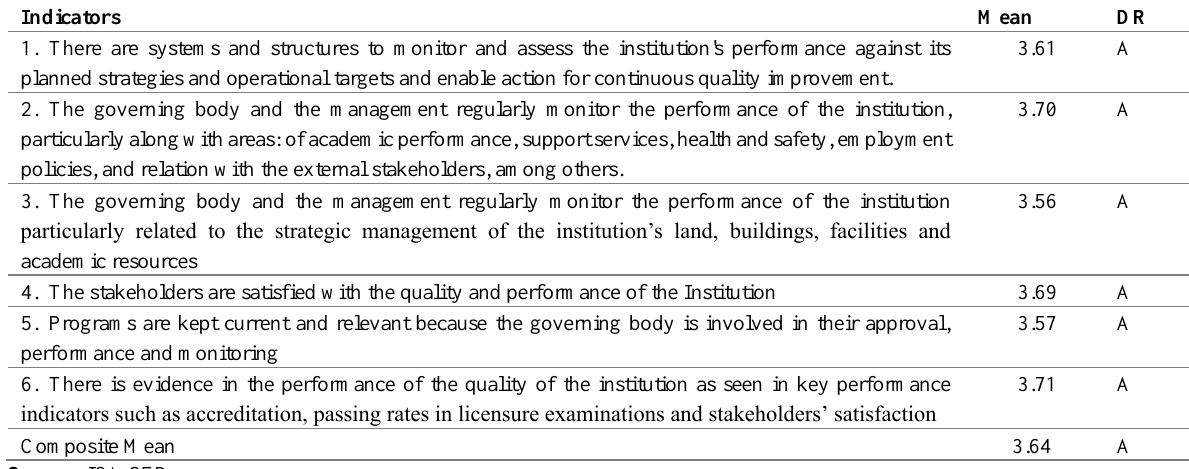
Table 5: Corporate Governance in terms of Effective Monitoring of Performance